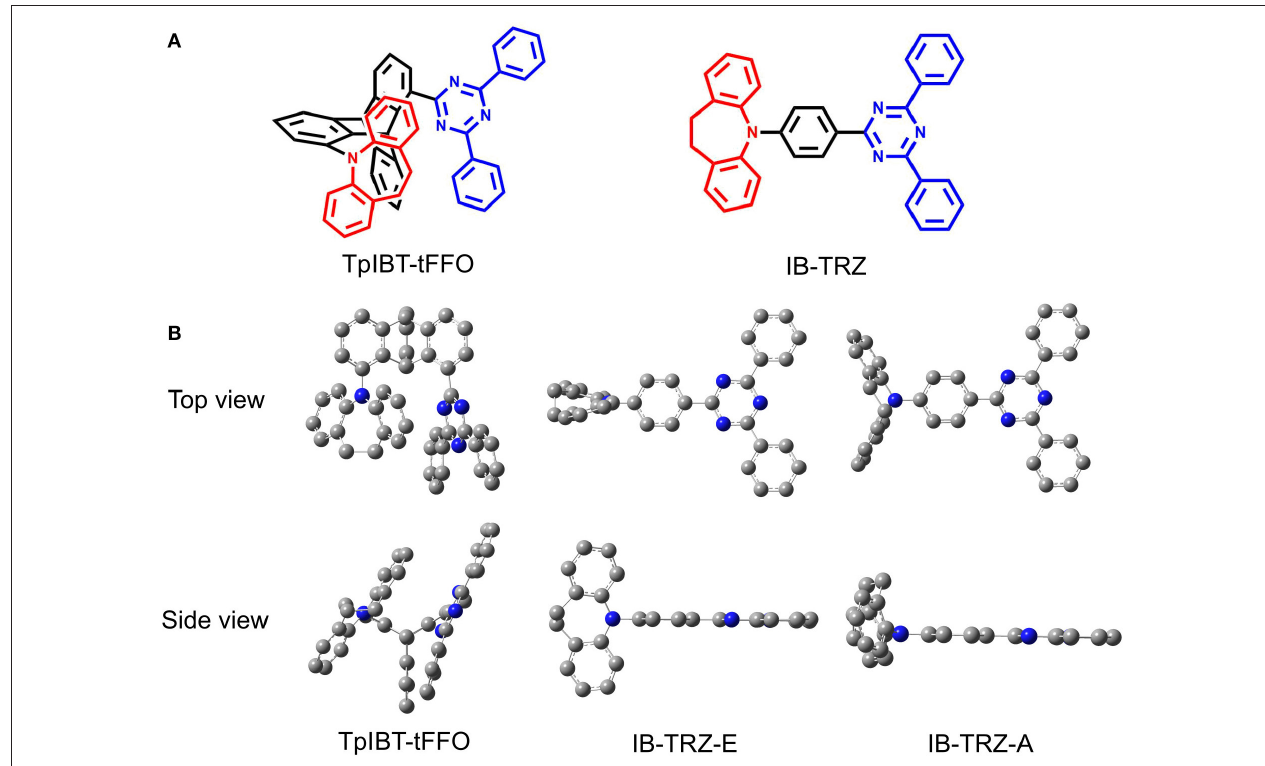
FIGURE 1 | (A) Chemical structures of TpIBT-tFFO and IB-TRZ. (B) DFT-optimized geometries of TpIBT-tFFO and